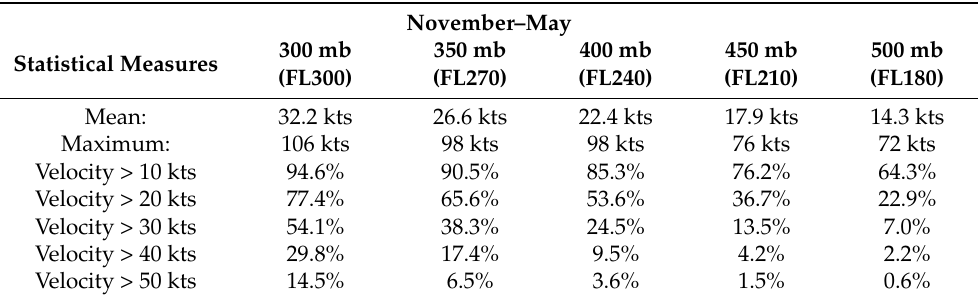
Table 4. Data of the mean, maximum and accumulated frequency of wind speed at levels from 500 to